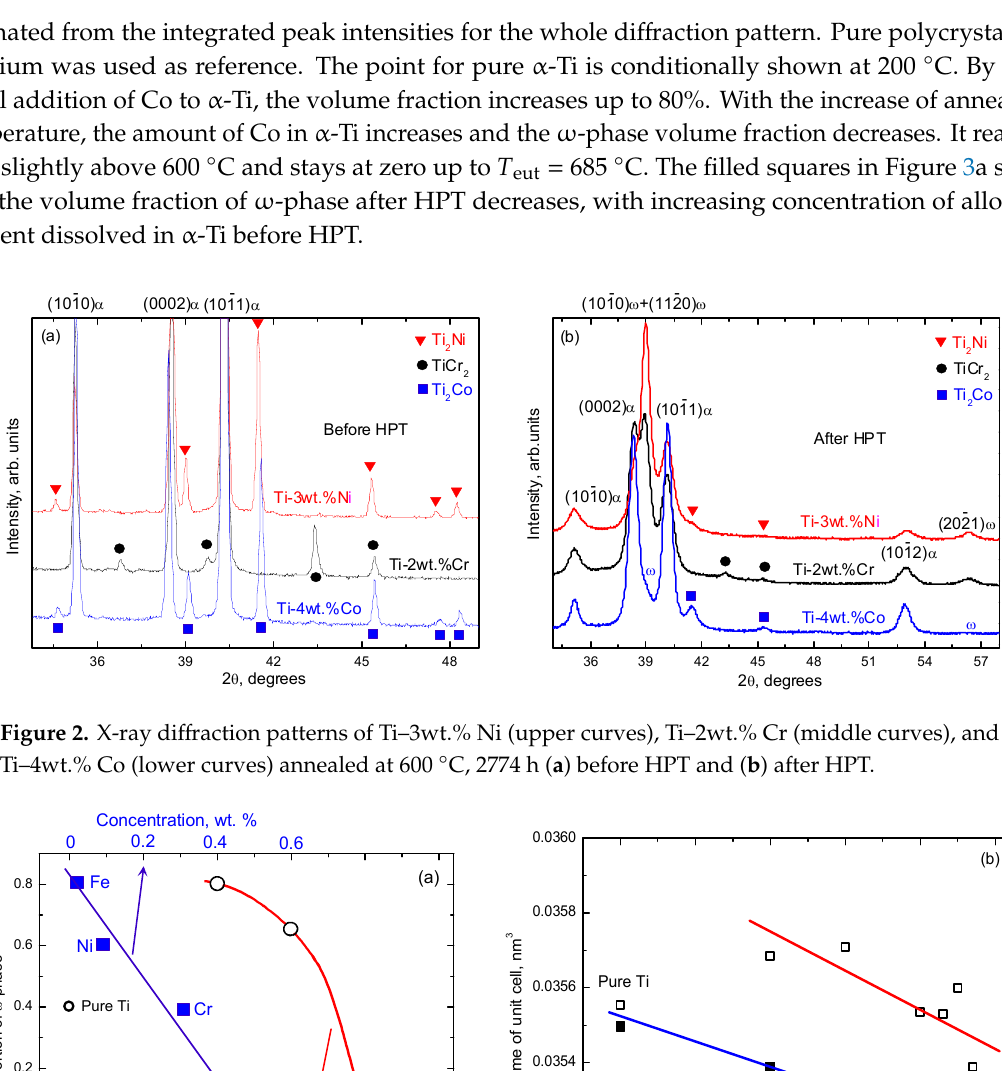
Figure 3. ( a ) The dependence of ω-phase portion after HPT in Ti–4wt.% Co alloy on temperature (open circles) and on concentration of β-stabilizers (blue solid squares). The values of ω-phase portion for different β-stabilizers are measured at 600 °С for Co, Cr, Ni, and at 470 °C for Fe. ( b ) Temperature dependence of the crystal cell volume calculated from XRD patterns for α-Ti in Ti–4wt.% Co alloy before HPT (filled black squares) and after HPT (open squares). The volume of hexagonal unit cell of ω-phase is equal to (3 0.5 a 2 c )/2 where a and c are lattice parameters.